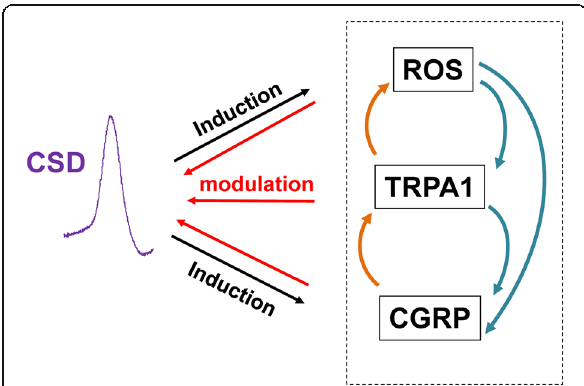
Fig. 7 A diagram depicting ROS/TRPA1/CGRP signaling in modulating cortical susceptibility to CSD. It is proposed that ROS may trigger TRPA1 activation and CGRP production, which create a positive feedback loop in regulating cortical susceptibility to CSD. In which way, ROS could facilitate CSD propagation for the subsequent development of